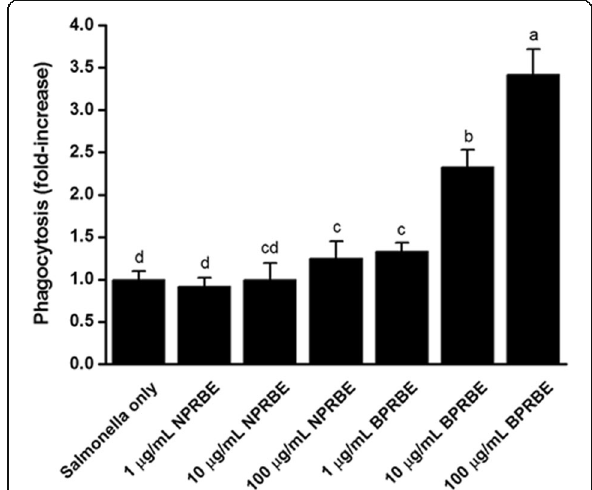
Fig. 3 Dose-dependent change in the phagocytotic effects of BPRBE on S. Typhimurium-infected macrophages. RAW 264.7 cells (1 × 10 4 cells) were incubated with three concentrations of BPRBE and NPRBE (1, 10 and 100 μ g/mL) for 4 h and were then infected with S. Typhimurium SL1344 (1 × 10 4 CFU). After incubation for 60 min, bacteria-infected macrophages were cultivated in the presence of gentamycin (30 μ g/mL) for 30 min. Bacterial internalization efficiency was determined by measuring the protection of internalized bacteria against bactericidal action of the antibiotic gentamycin. Data are expressed as the mean ± SD of triplicate experiments. Bars sharing a common letter are not significantly different between groups at p <